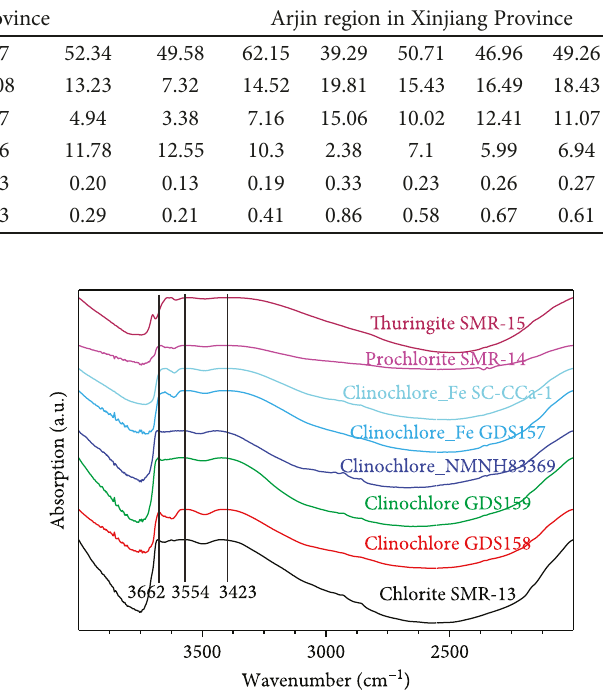
Table 2: Mineral components of chlorite samples collected from two regions in this study. Components/ samples